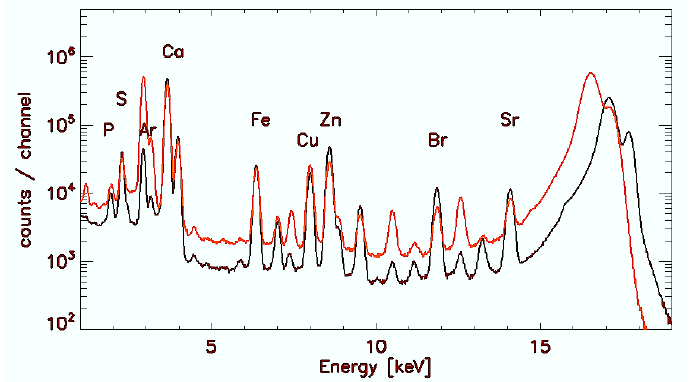
Figure 1. Accumulated spectra after summation over all pixels with peaks of the investigated elements. Red colour: Control–GB. Black colour: Wilson’s Disease-GB.